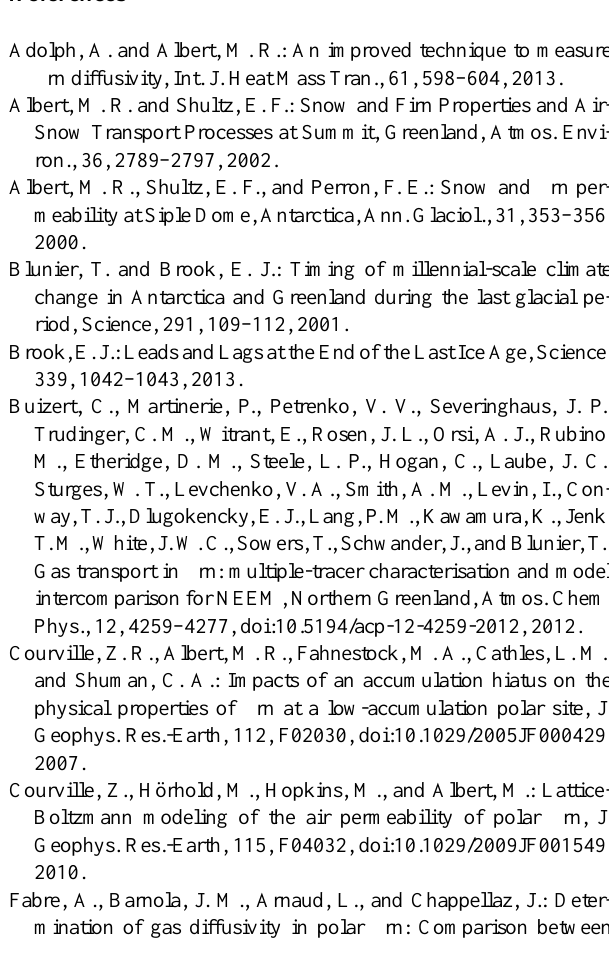
(cid:16) D (cid:17) 2 . 79 f D a